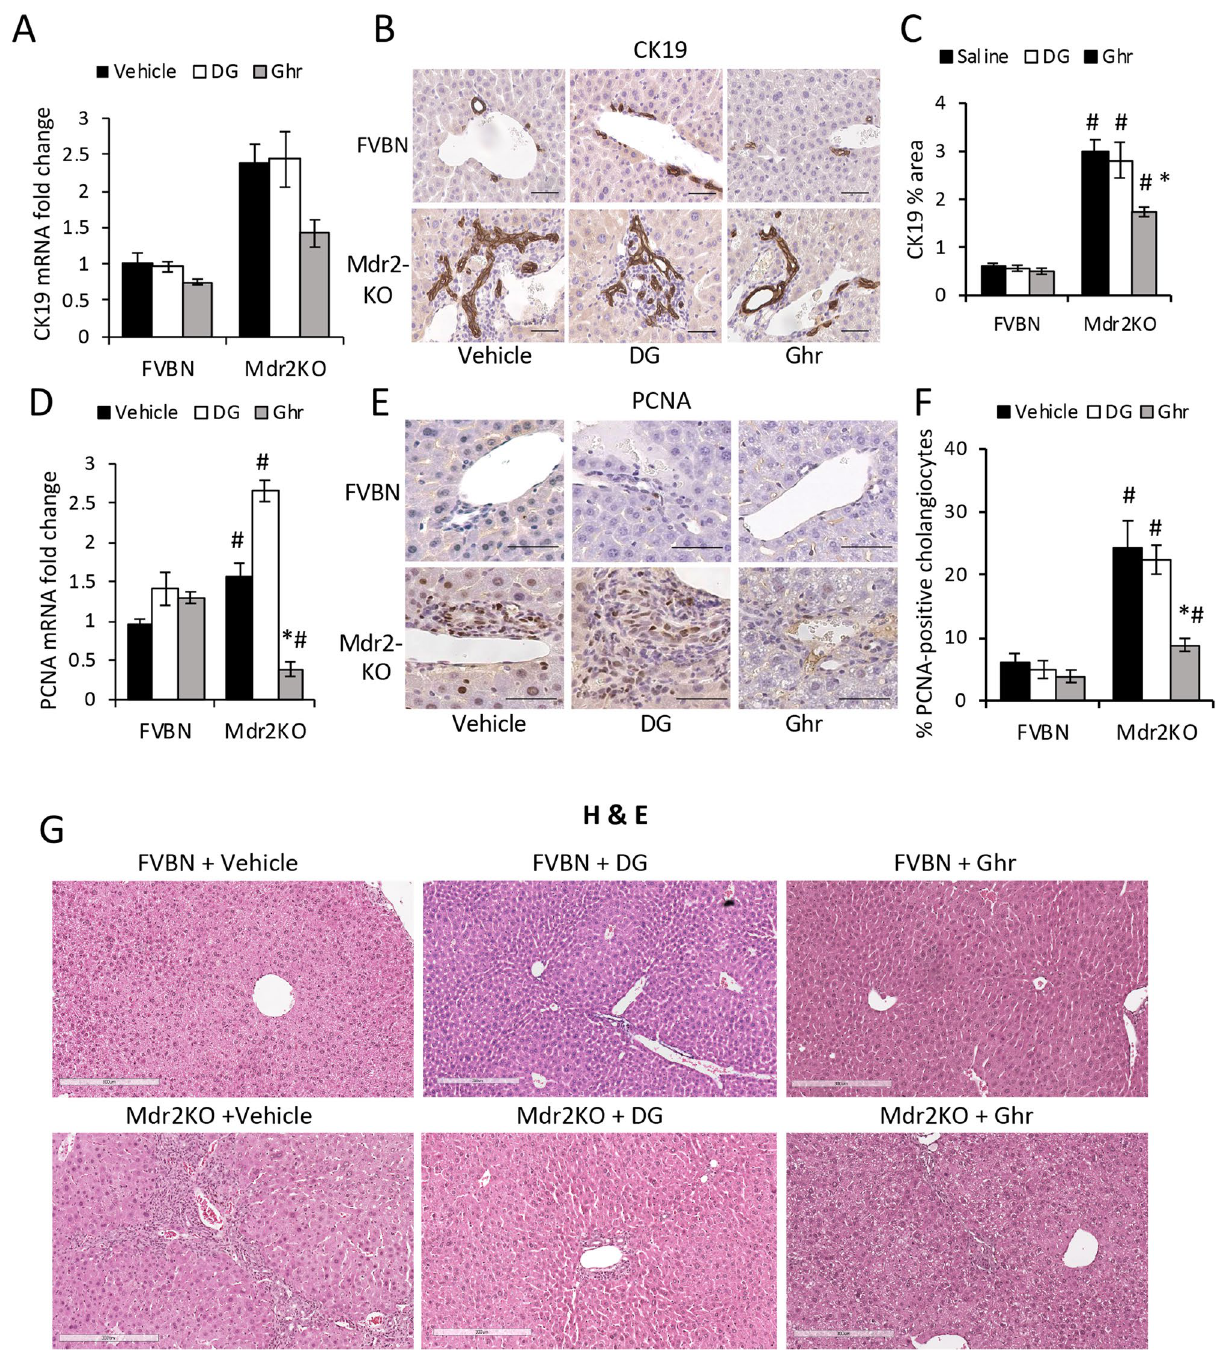
Figure 5. Ghr reduces the IBDM in Mdr2KO mice. Liver samples from male Mdr2KO and FVBN mice treated with vehicle, DG or Ghr, were tested for expression of CK19 mRNA, by RT-qPCR (A) and CK protein by IHC (B, C) . (B) Representative images of CK19 (marker of cholangiocytes) IHC. (C) Quantification of CK19 expression by image analysis using ImageJ software. PCNA, a marker of cell proliferation was also tested at RNA (D) and protein (E, F) level using RT-qPCR and IHC, respectively. (E) Representative images of PCNA IHC. (F) Quantification of PCNA-expressing cholangiocytes by analysis of IHC images. p < 0.05. * DG or Ghr vs vehicle. #, Mdr2KO vs FVBN mice. Number of animals in each treatment group, 4. Number of sample replicates in RT-qPCR assay, 3. Number of images from each animal in a treatment group, in IHC assay, 10. G, Representative images of H&E staining of liver tissue from male and female FVBN (control) mice and Mdr2KO (cholestatic) mice treated with vehicle, DG or